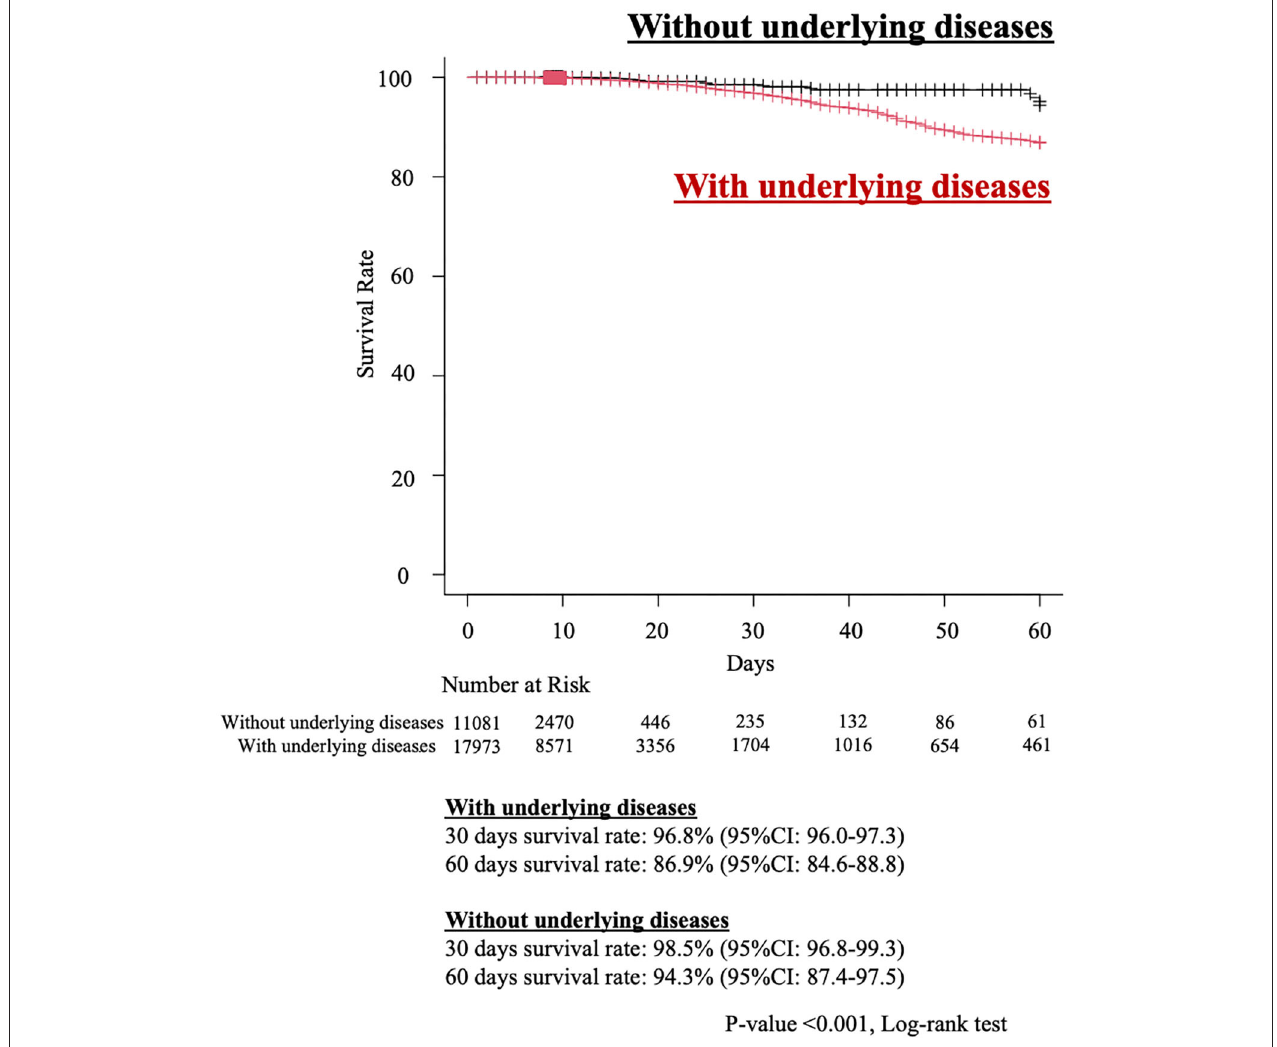
FIGURE 2 | Estimated Kaplan–Meier overall survival curve of herpes zoster patients with or without underlying diseases. 95% CI, 95 percent confidence interval.